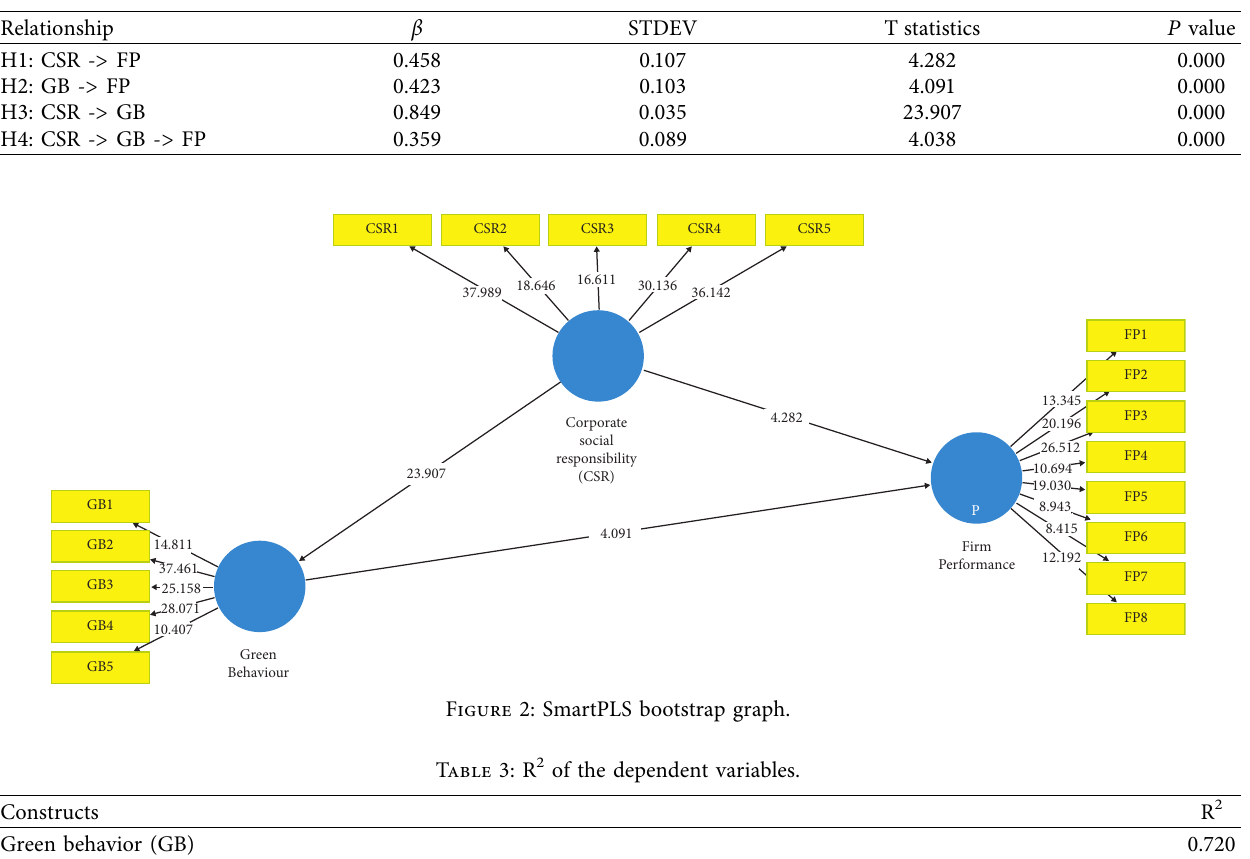
Table 2: Mean, STDEV, T values, and P values.